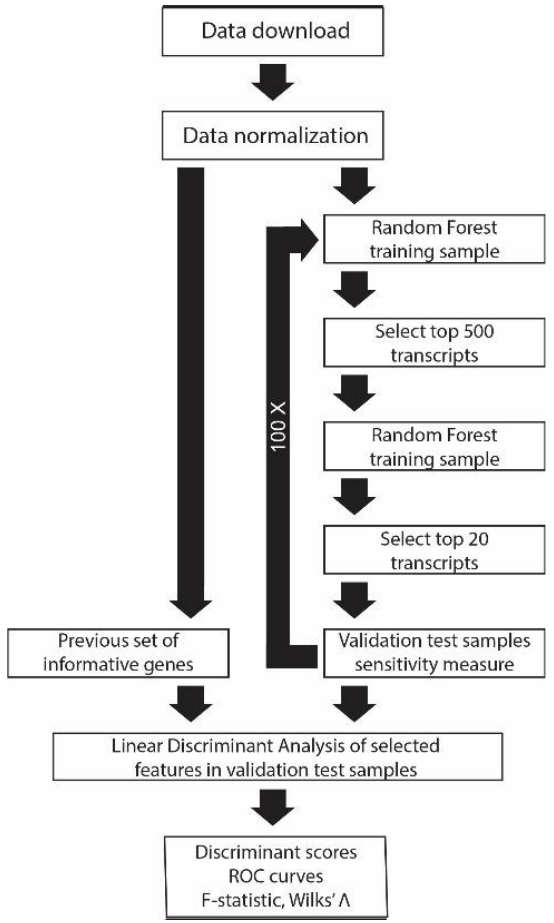
Figure 1. Schematic of analysis method. Selection of predictive transcripts were made ad hoc from empirical data research and subjected to validation by linear discriminant analysis (left side). A machine learning algorithm generated new predictive transcripts for classifying disease from healthy controls (right side), subsequently validated using linear discriminant